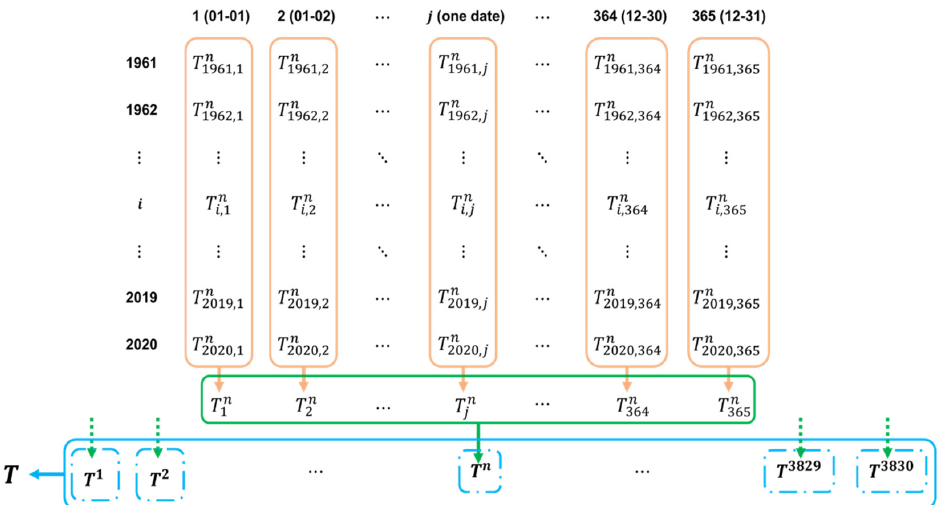
Figure 1. The set in the module highlighted in green is used to calculate the 90th percentile of the maximum temperature at one grid point. The set in the module highlighted in orange is used to calculate the anomaly and standard deviation of maximum temperatures at one grid point on one calendar day. It can be easily understood that we set 3830 different thresholds for PTM and 3830 × 365 = 1,397,950 different thresholds for FATM or VATM. n T represents th n grid point for 60 years. The mean repre- T represents the set maximum tempera- sents the function for calculating the average. n j th j th n grid point on the calendar day in each year. std is a function for ture at the calculating the standard deviation.